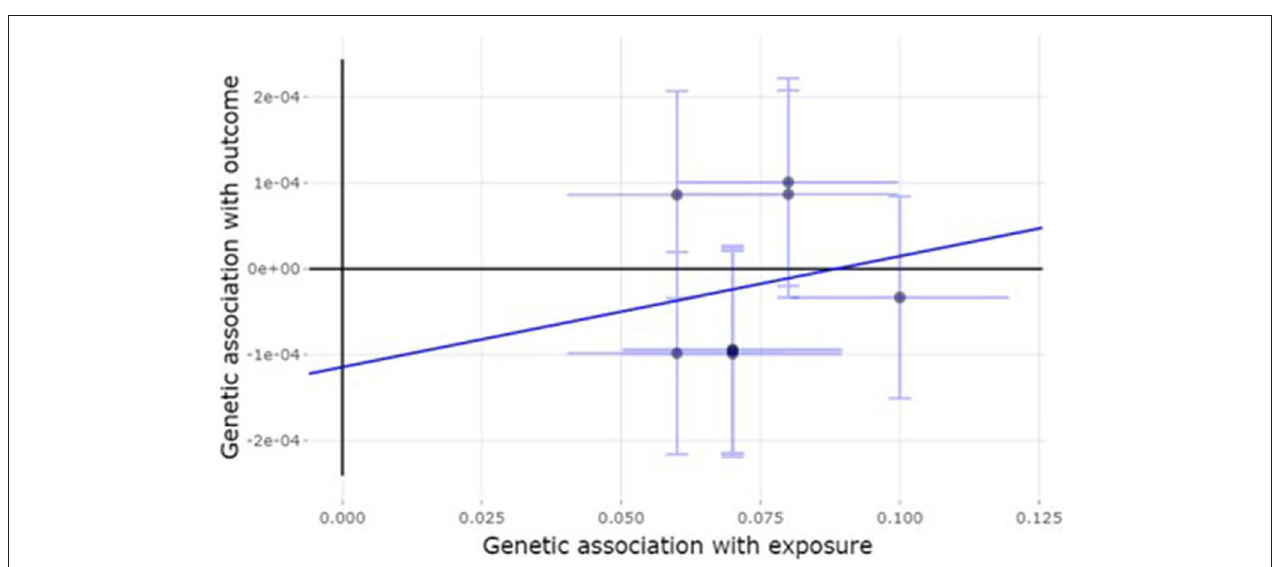
FIGURE 4 | The estimate of horizontal pleiotropy based on MR-Egger analysis.